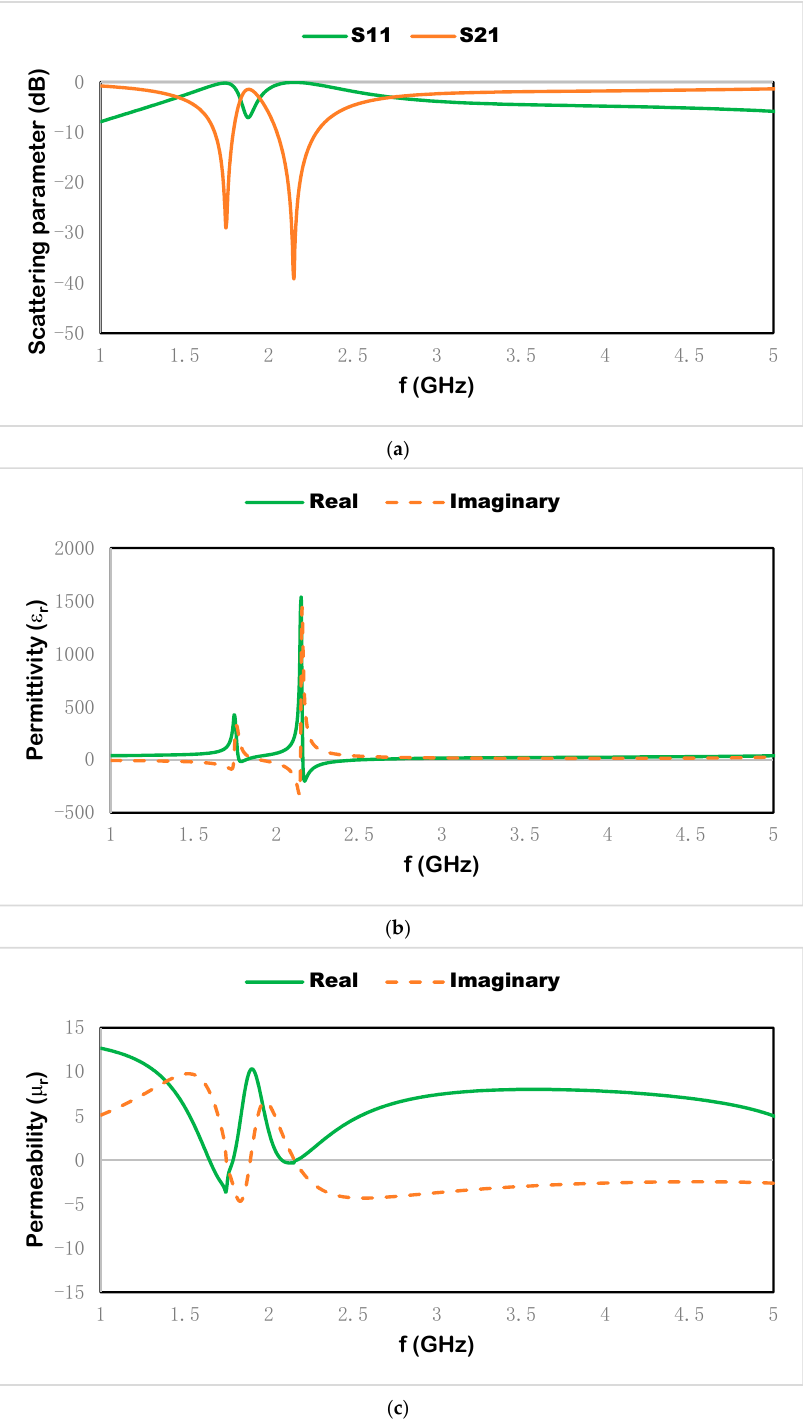
Figure 6. ( a ) Scattering properties, ( b ) effective permittivity, and ( c ) effective permeability.